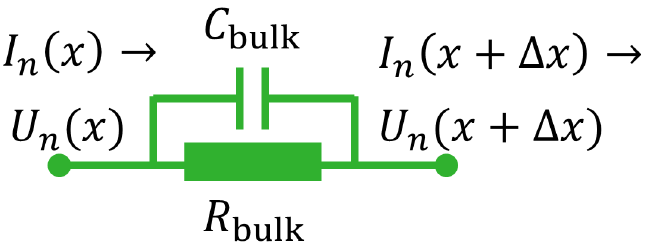
Figure 7. Equivalent circuit representation for the horizontal electrical bulk properties of a slice of traxel ∆ x